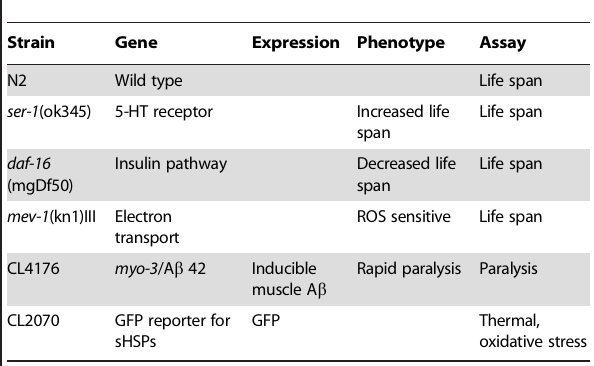
Table 2. Description of C. elegans strains.